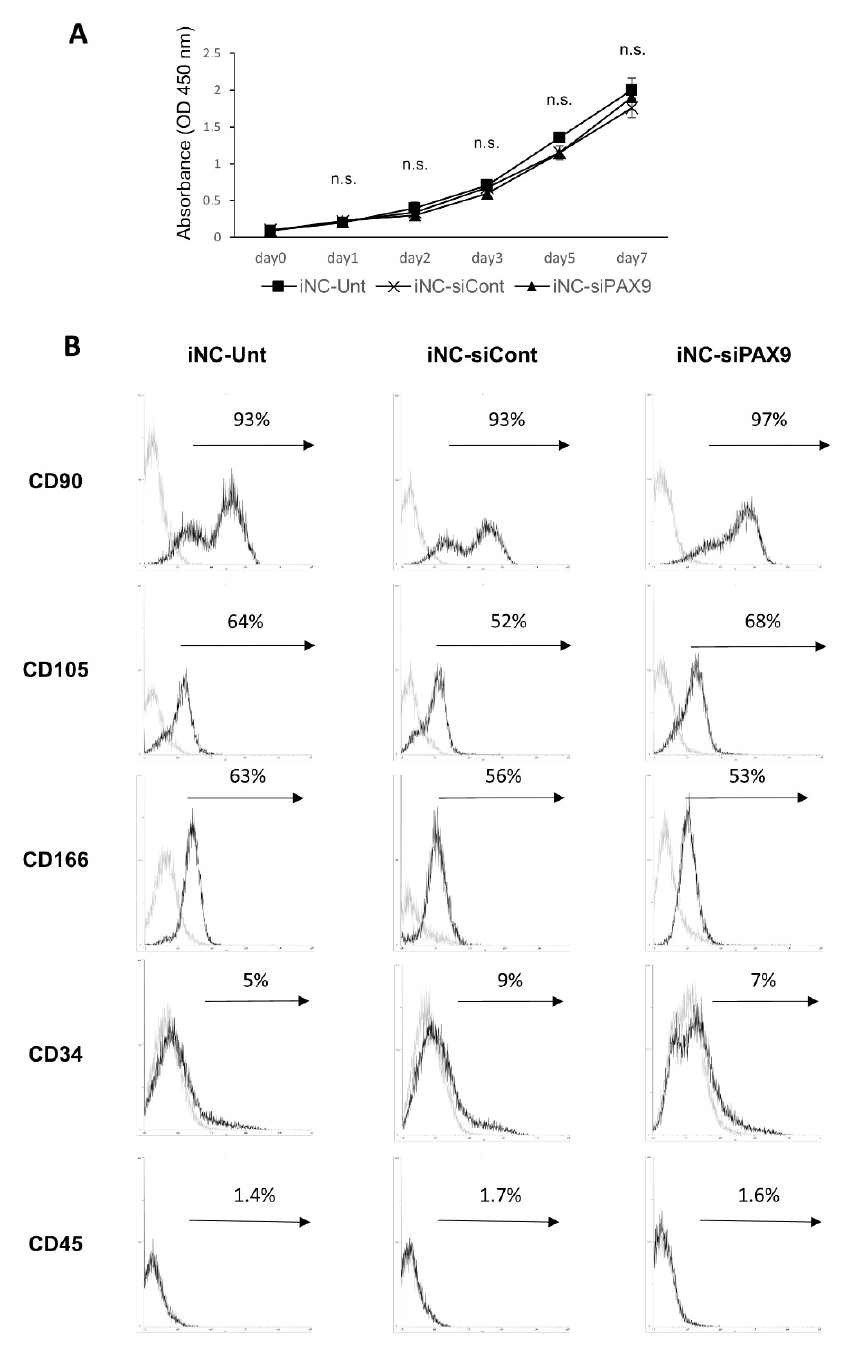
Figure 4. No significant difference in proliferative capacity and cell surface antigen marker expression between iNC-Unt, iNC-siCont, and iNC-siPAX9. ( A )Proliferation of iNC-Unt, iNC-siCont, and iNC-siPAX9 determined by WST-1 assay. ( B ) Flow cytometric analysis of MSC (CD90, CD105, and CD166)- and hematopoietic cell (CD34 and CD45)-associated surface marker expression in iNC-Unt, iNC-siCont, and iNC-siPAX9. Histograms depicting fluorescently labelled cells with MSC- and hematopoietic-associated markers (black lines), and isotype-matched control (gray lines). n.s., not significant; iNC, induced pluripotent stem cell-derived neural crest-like cells; MSC, mesenchymal stem cell.